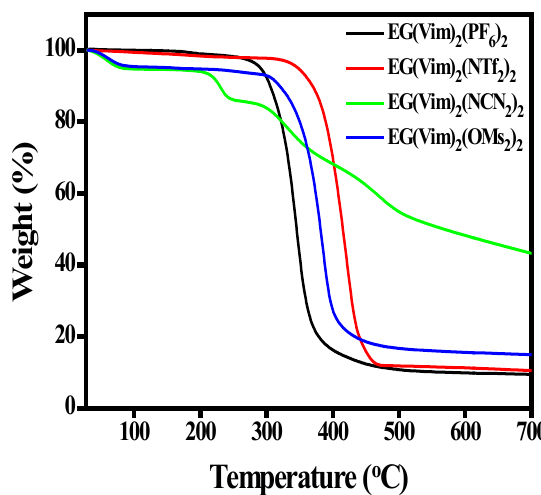
Figure 1: Thermogravimetric (TGA) analysis of synthesized di-cationic